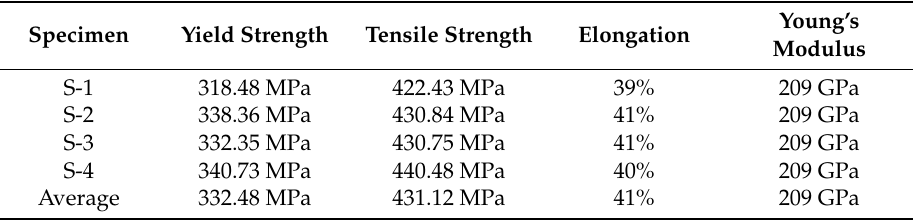
Table 2. Results of structural steel tensile strength test.